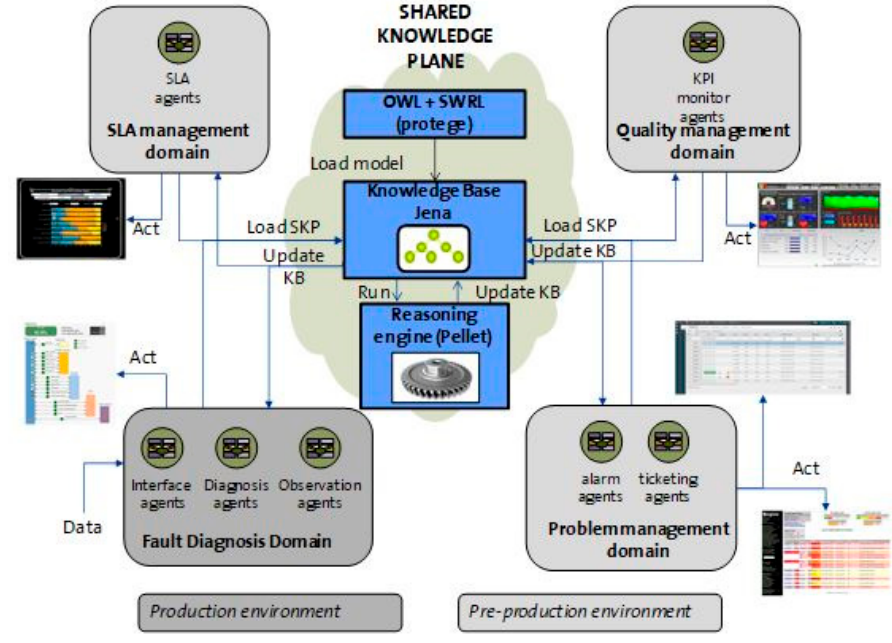
Figure 6. Shared Knowledge Plane schema.